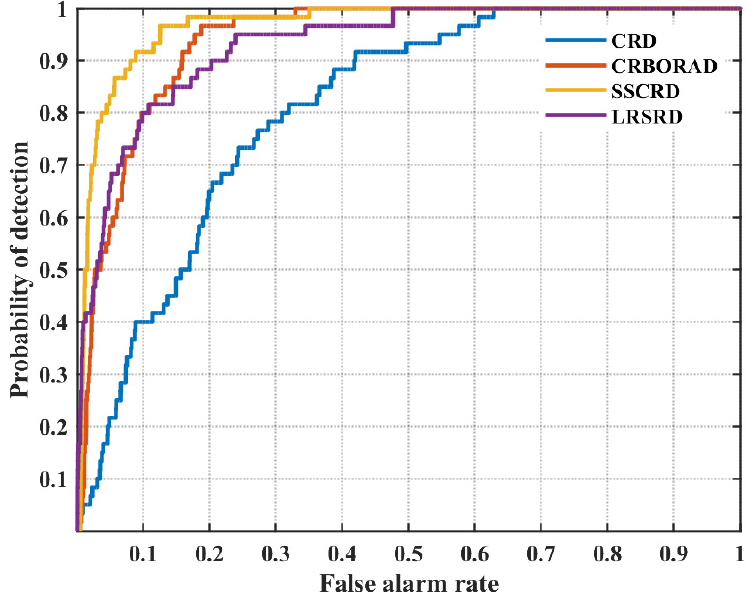
Figure 7. ROC curves for ABU Airport image dataset with dual-window sizes (11,15) for CRD, CRBORAD, and SSCRD.